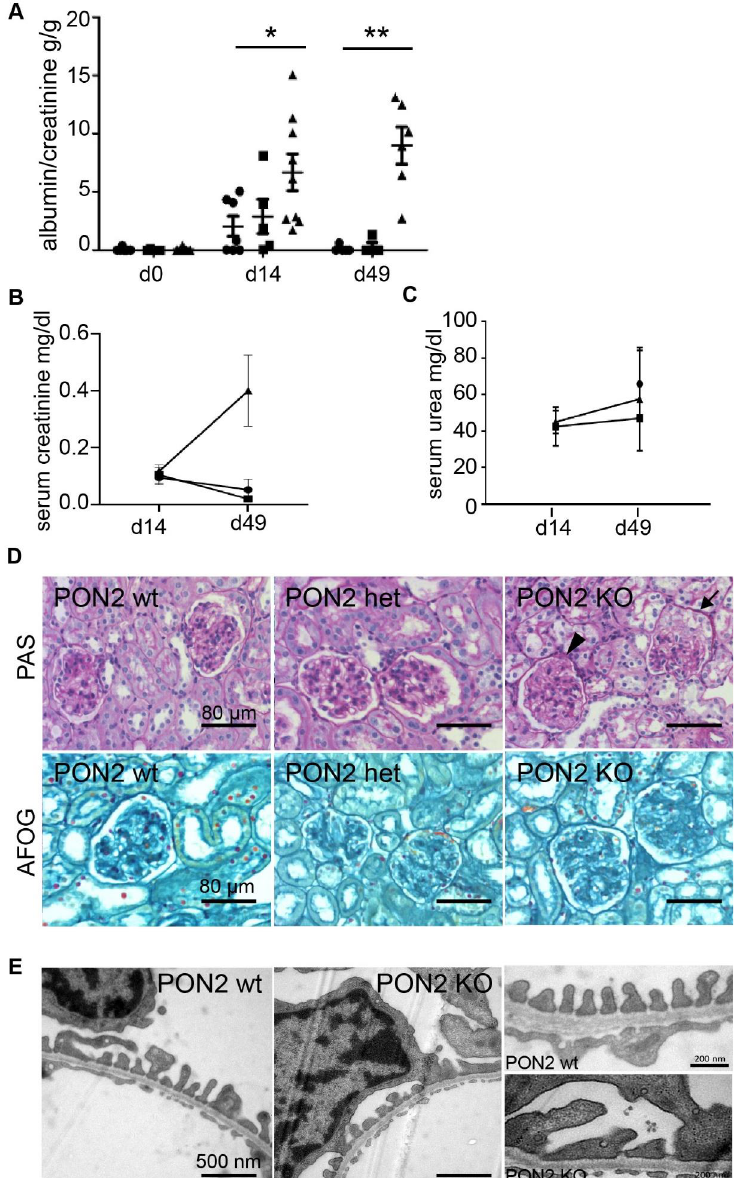
Figure 4. PON2 deficiency aggravates the glomerular phenotype of adriamycin-induced nephropa- thy. Quantification of albuminuria in the AIN model on day 0, day 14, and day 49 after adriamycin